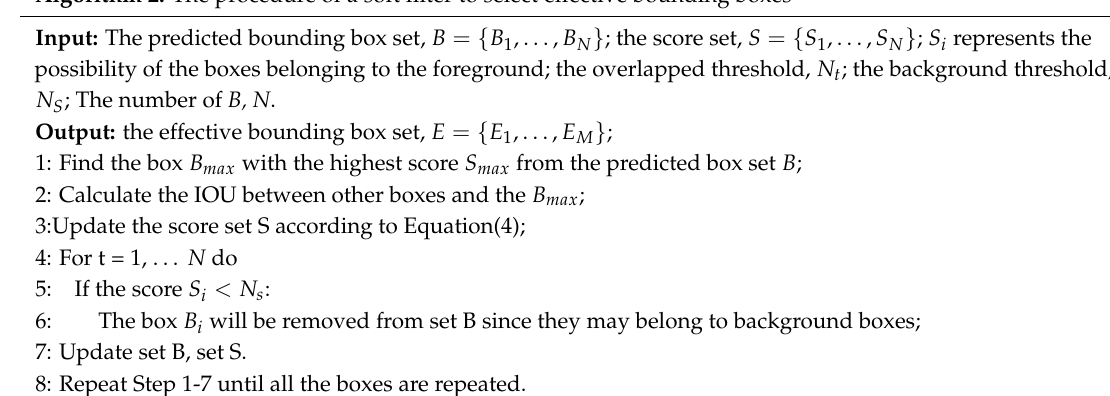
Algorithm 2. The procedure of a soft filter to select effective bounding boxes